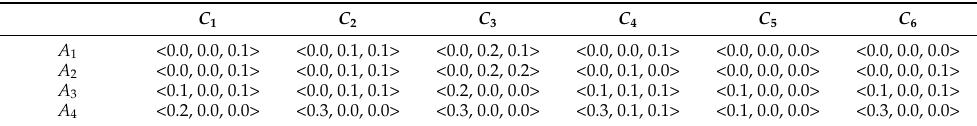
Table 6. The SVNNDA.